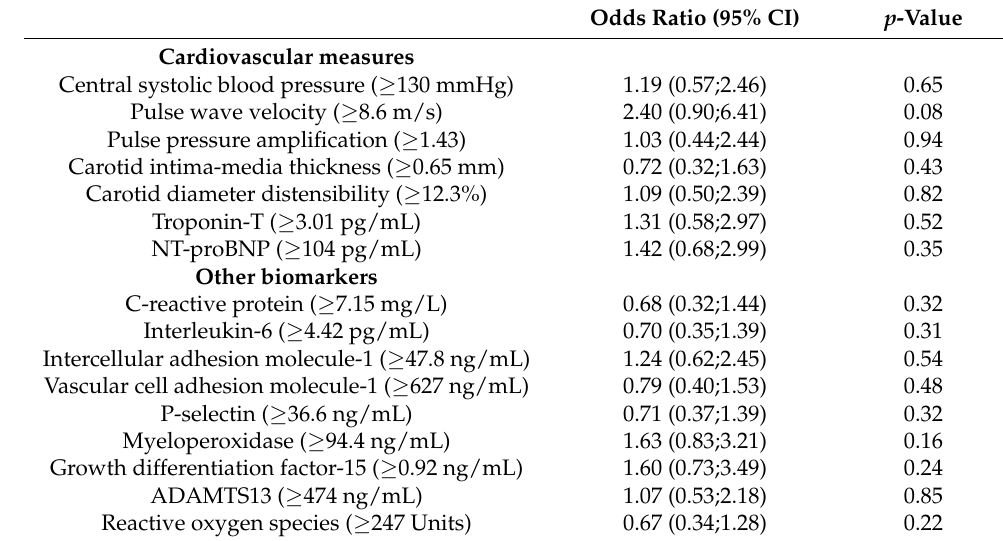
Table 3. Odds of having cardiovascular measures and biochemical markers above the 75th percentile while having low-level viremia ( n =